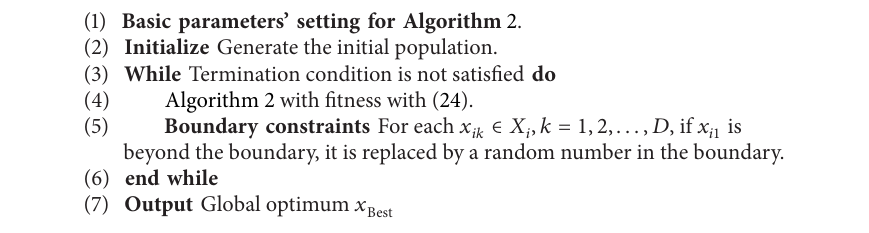
Table 1: Detail parameters setting for different systems.